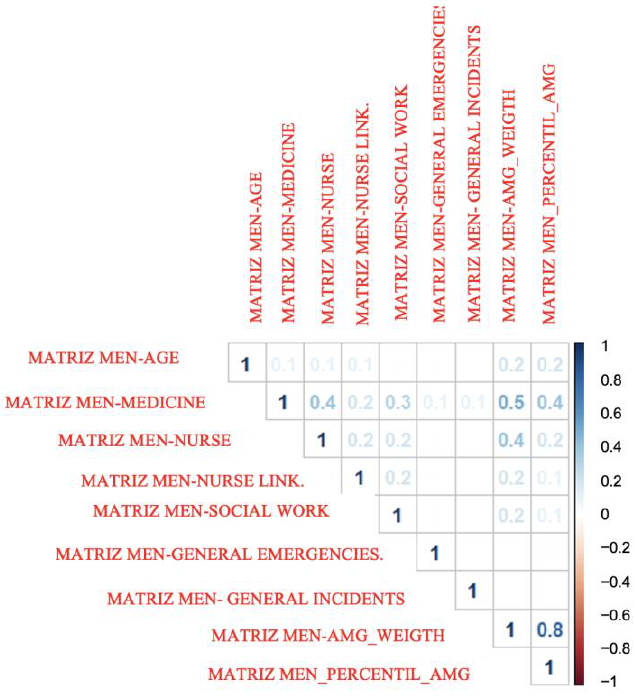
Figure 2. Correlations between all quantitative variables for men. Basic Health Areas of Gran Canaria. 2018–2020. Correlation coefficient.